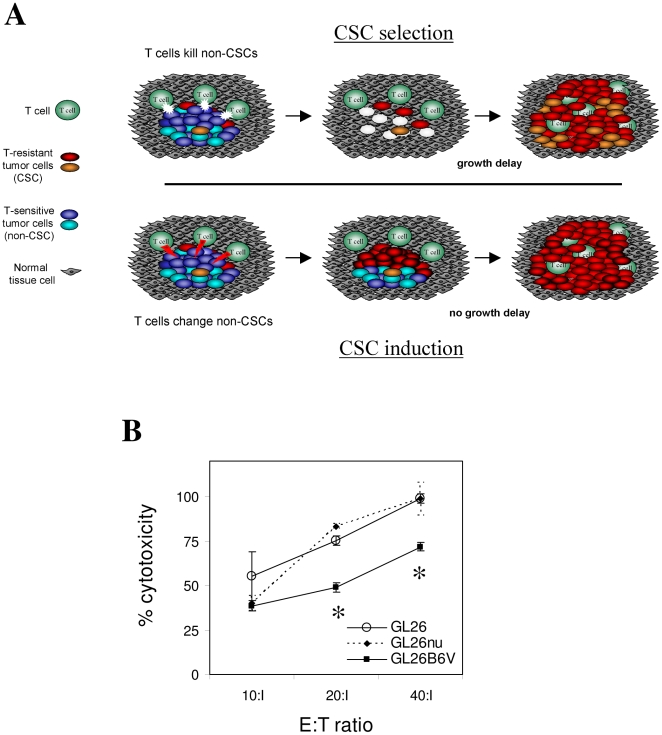
Selection vs. induction of stem-like properties in gliomas.(A) Expected appearance of gliomas under alternative mechanisms of selection of pre-existing glioma stem cells (top panel) vs. induction of stem-like genetic program (bottom panel) via vaccination. The present data best support the occurrence of immune-mediated glioma CSC selection with or without prior immune induction of these cells. (B) Vaccine-exposed (GL26B6V) and parental GL26 were co-incubated with indicated ratios of HTB-156.7.7 (an H-2Kb-reactive T hybridoma [39]), and assessed for killing. A representative of 3 independent assays is shown. GL26B6V exhibited relative resistance to killing, consistent with a selection mechanism for T cell-mediated enrichment of stem-like gliomas. Asterisks denote significantly reduced specific lysis in triplicate wells (P>0.05 by single-sided T-test).